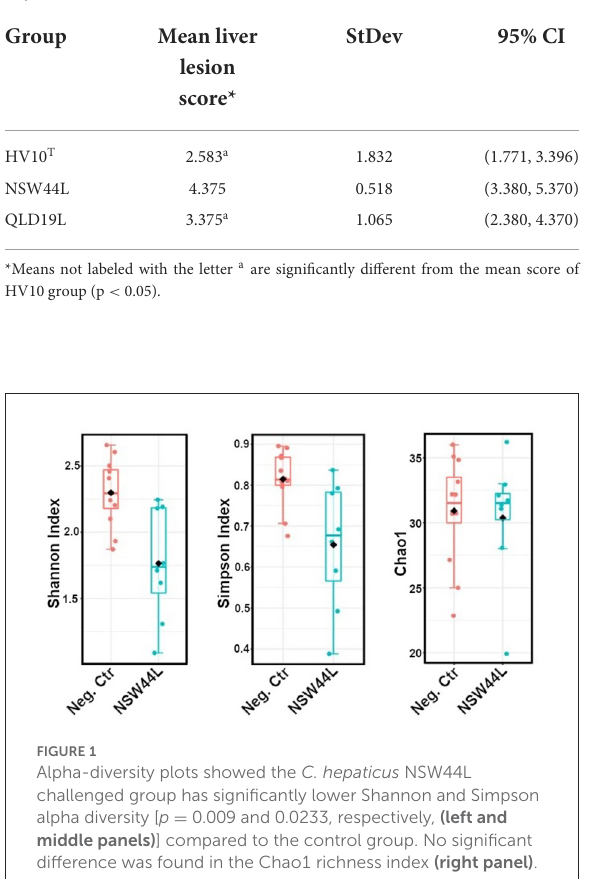
TABLE 1 Live lesion scores of birds challenged with different C. hepaticus strains.